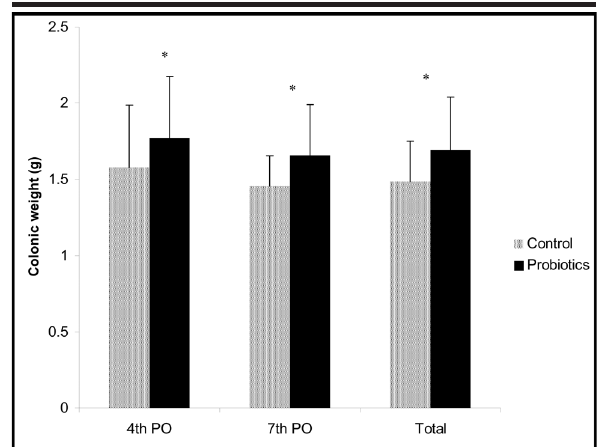
FIGURE 1 - Colonic weight without feces in the two groups. Data are mean and SD. * p<0,05 vs control